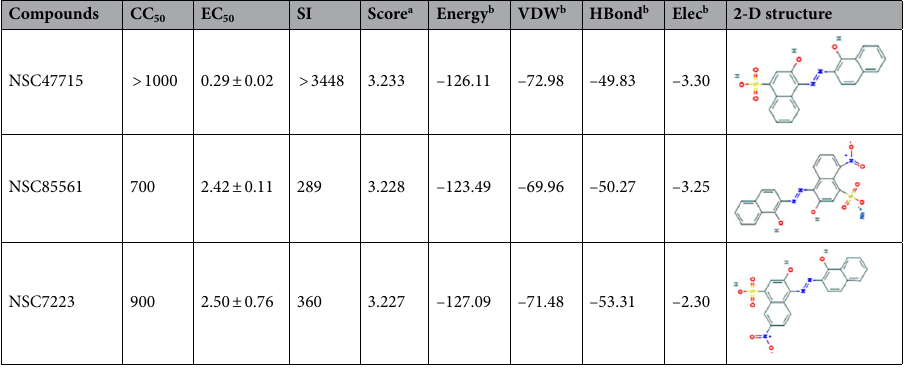
Table 2. CC 50 (µM) , EC 50 (µM) and SI values for NSC47715, NSC85561 and NSC7223. The EC 50 value is presented as the mean ± standard deviation. CC 50 cytotoxic concentration 50%, EC 50 half-maximal